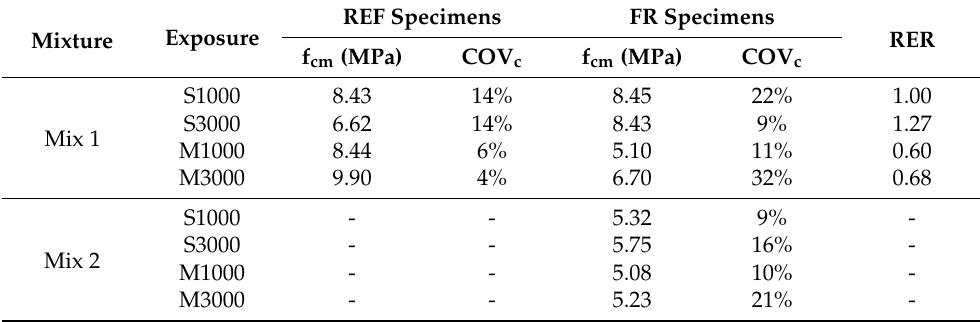
Table 7. Results of compression strength of C specimens subjected to saline and moisture conditioning.